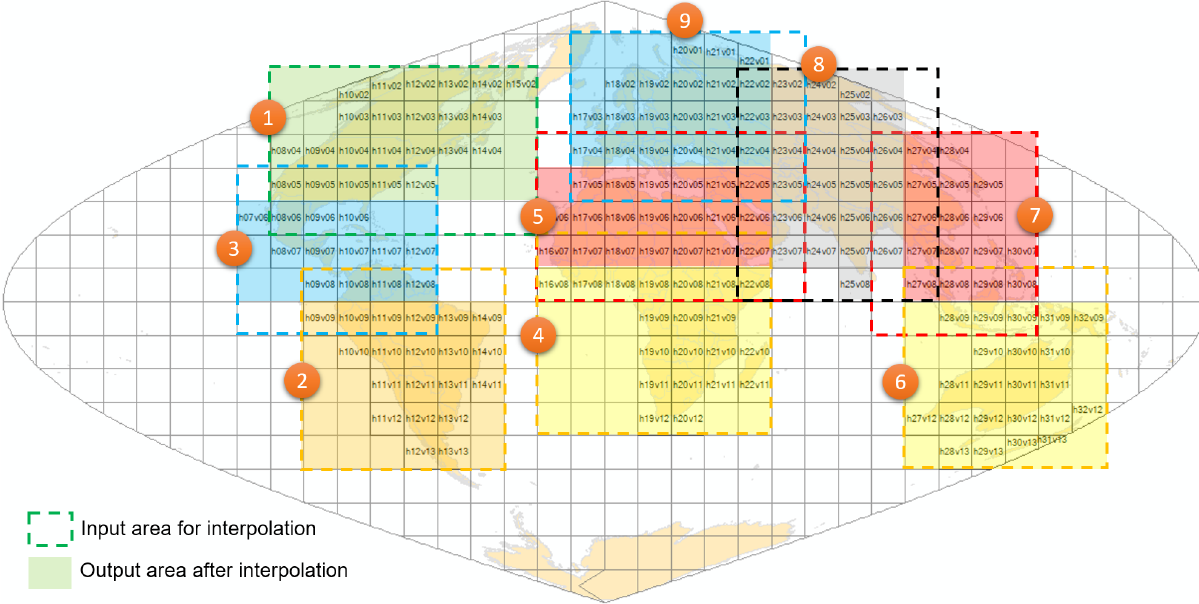
Figure 4. Division of global regions. Dashed and shaded rectangles indicate the extent of input data and output data,